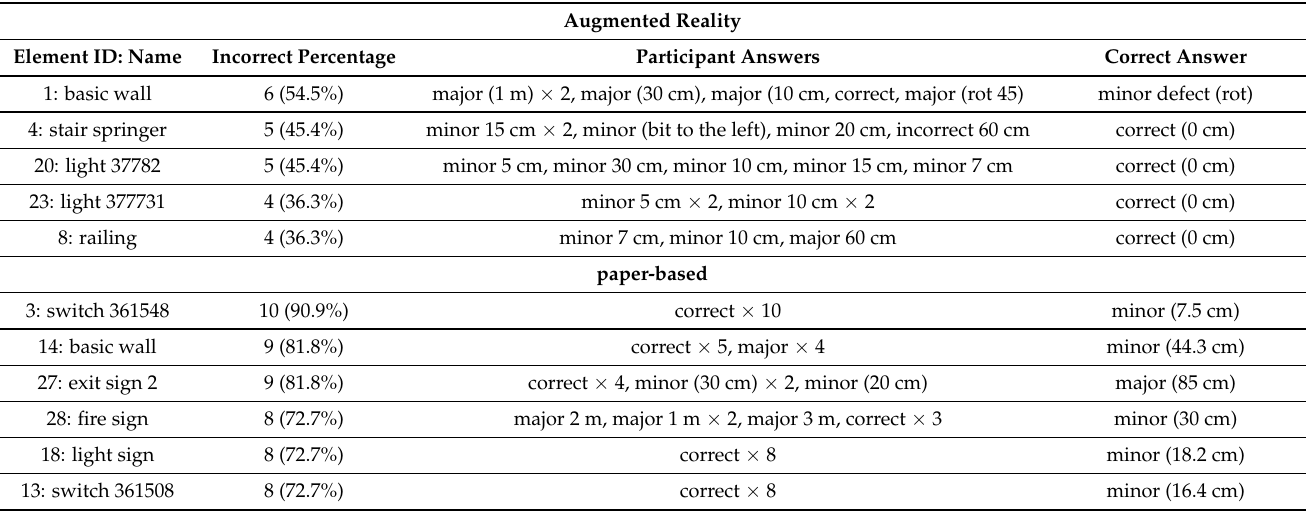
Table 5. This table presents a comparison of the most-common errors made during the inspection when using the paper-based and AR